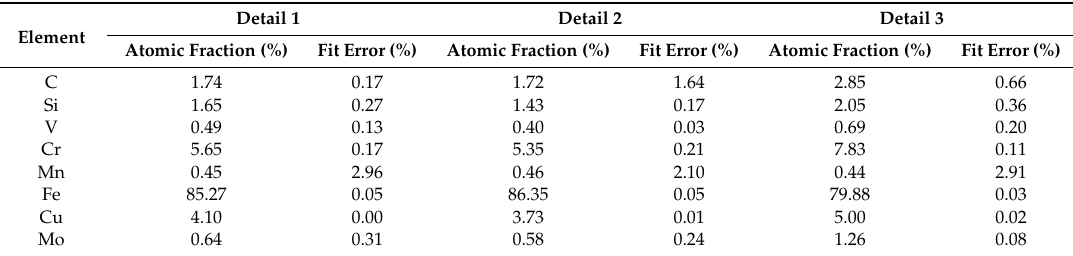
Figure 8. Lamella of Sample 64 of 1.2363 steel (electrode material: copper, electrode shape 100 mm × 100 mm) together with three different details where the chemical composition analysis was performed. Table 4. Analysis of the chemical composition in each detail according to Figure